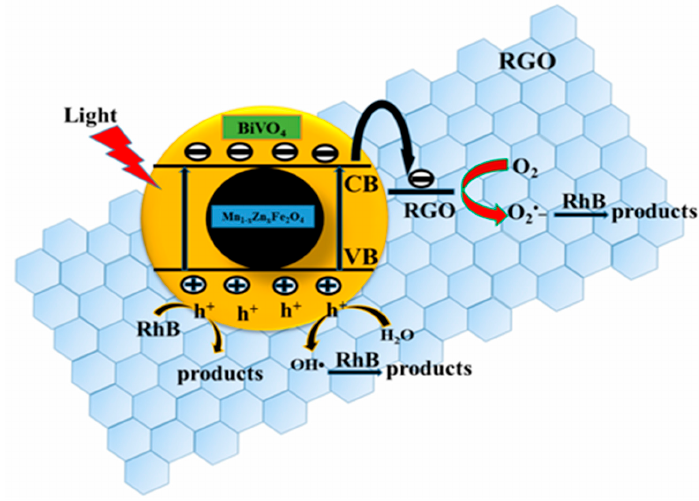
Figure 13. Photocatalytic scheme of BiVO 4 /Mn 1-x Zn x Fe 2 O 4 /RGO under visible light irradiation.